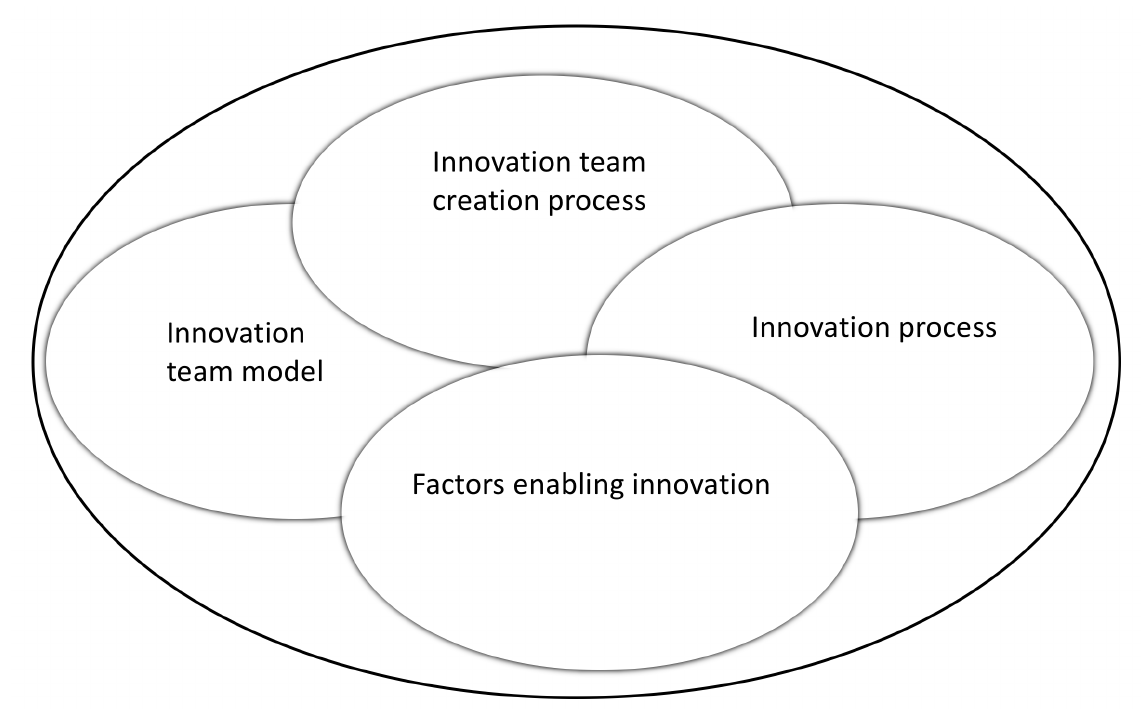
Fig. 7 . The figure demonstrates the facilitator’s areas of